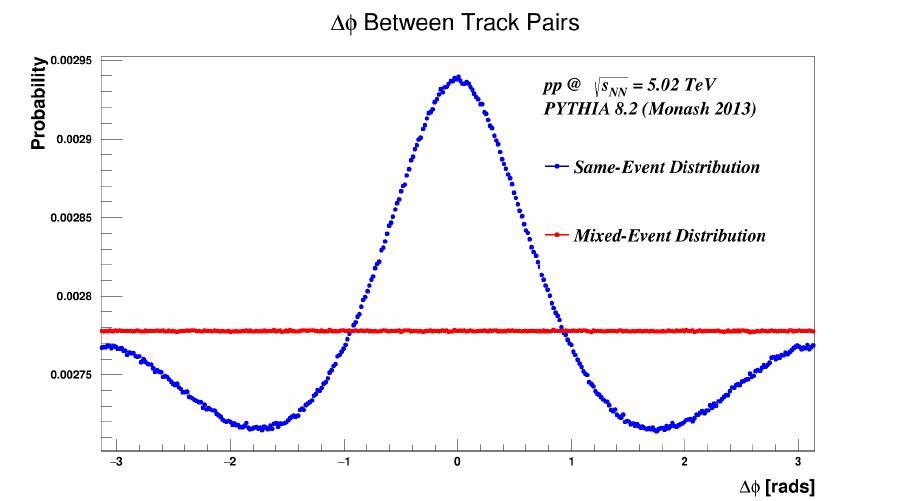
Figure 3. The ∆ φ distribution for track pairs from both mixed-events and same-events.